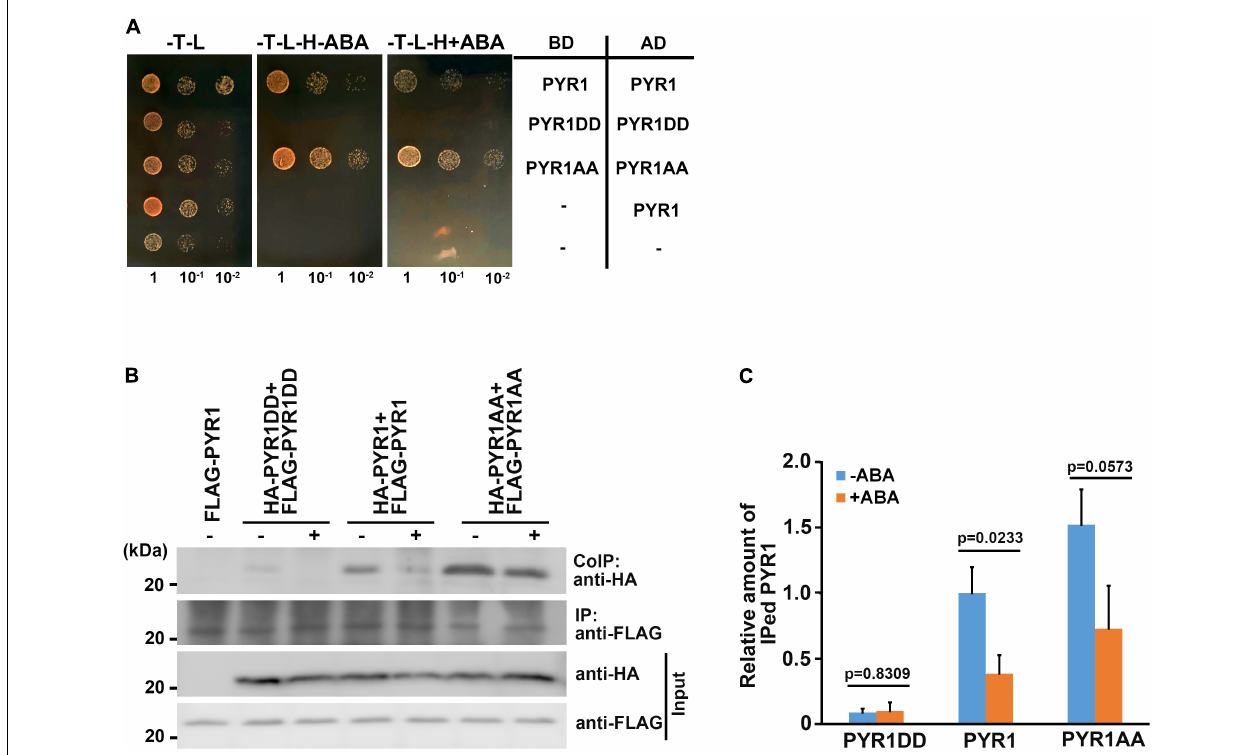
FIGURE 6 | BAK1 phosphorylation of PYR1 resulted in reduced dimer formation of PYR1. (A) PYR1 phosphorylation by BAK1 plays a negative role in PYR1 dimer formation. Each monomeric form of PYR1 bound to the DNA binding domain or activation domain of the GAL4 transcription system was constructed, and transformed as indicated. Yeast cells were grown up to 0.6 at OD600 (set as 1) Tenfold, serially diluted cell cultures were inoculated on each spot as indicated. (B) PYR1 dimerization is suppressed by BAK1-mediated phosphorylation of PYR1. Co-immunoprecipitation assays were performed using tobacco leaves transiently expressing pairs of PYR1 variants containing HA- or FLAG tags with or without ABA. HA-tagged PYR1 was immunoprecipitated using anti-HA antibodies, and co-immunoprecipitates were identified using anti-FLAG antibodies. (C) Relative amounts of co-immunoprecipitated PYR1, PYR1DD, or PYR1AA in total proteins from each tobacco leaf were quantified using Image J software from the picture in (B) and two independent experiments as shown in Supplementary Figure 7d . The P -values from a two-sided t -test (compared with the ABA-untreated sample) are shown to indicate